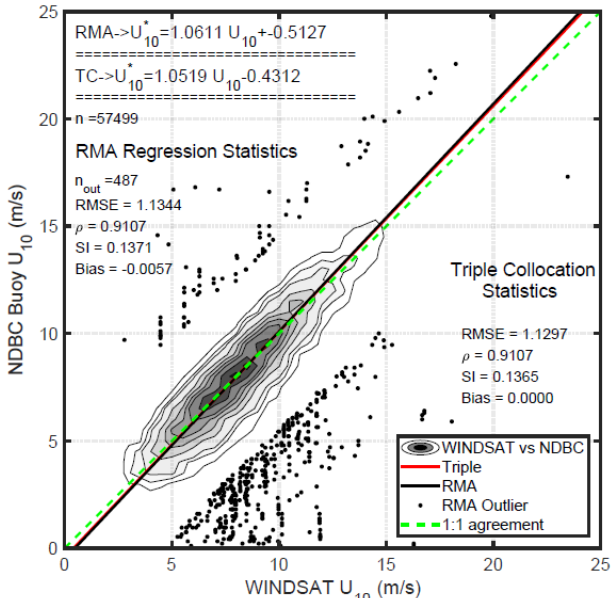
Figure 5. Calibration of WINDSAT wind speed against NDBC buoy data using RMA and triple collocation. The contours represent the normalized density of data points, with contours drawn at 0.9, 0.7, 0.5, …, 0.1, 0.07, 0.04 (maximum value is one). Dots represent outliers excluded from RMA regression using robust regression. 𝑈 10∗ refer to calibrated values of wind speed and 𝑈 10 to uncalibrated values. n and n out are the number of clean (i.e. not outliers) collocated measurements and the number of outliers, respectively. Remote Sens. 2020 , x , x FOR PEER REVIEW